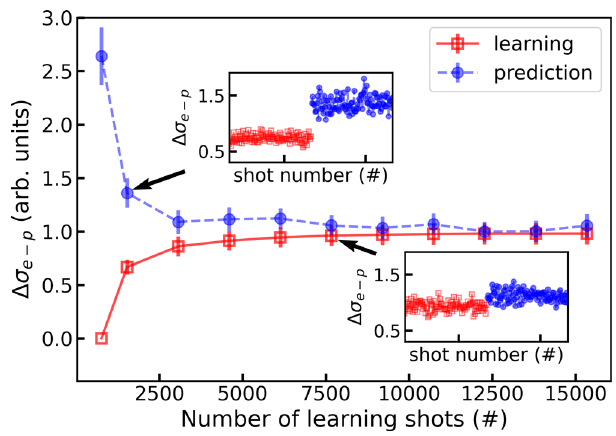
Fig. 5 Predictive capability of the ghost-imaging algorithm. Δ σ e-p (Eqn. (3)), the standard deviation between the ghost-imaging reconstructed and the true photon spectrum, is plotted as a function of the number of shots used in the regression to determin the response matrix R . Prediction refers to Δ σ e-p for 100 shots not used in the learning regression. The accuracy of the prediction increases (i.e., Δ σ e-p decreases) as the number of learning shots increases. The error bars represent standard deviations of Δ σ e-p . The inset at 1433 learning shots shows a marked difference between prediction and learning (0.6 vs 1.4), whereas the inset at 7568 learning shots shows a relatively small difference (0.9 vs 1.1).